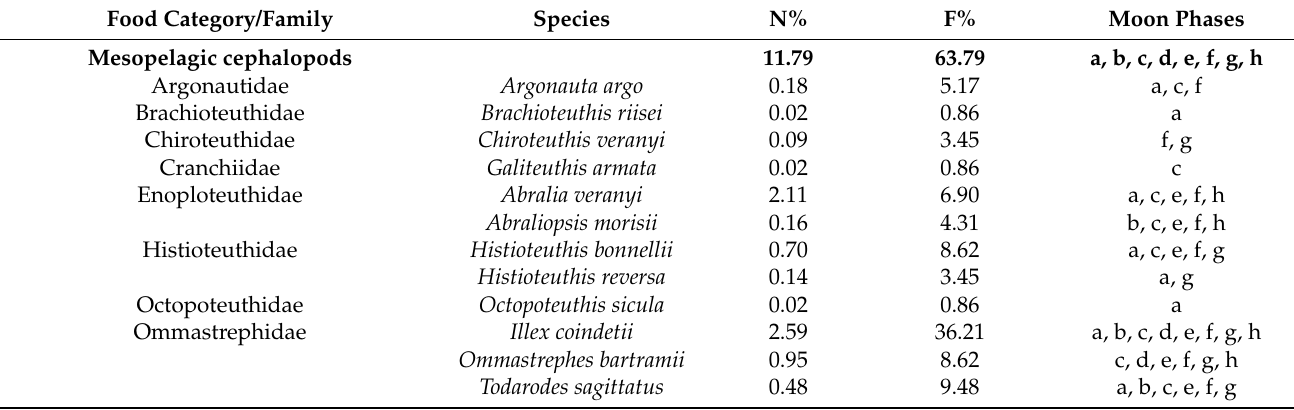
Table 1. Percentage abundance (%N) and frequency of occurrence (%F) of BFT mesopelagic cephalo- pod and fish prey (total values for other invertebrates and fish are also given). The column “moon phases” indicates the period of lunar cycle in which each prey was found (a: new moon; b: waxing crescent; c: first quarter; d: waxing gibbous; e: full moon; f: waning gibbous; g: third quarter; h: waning